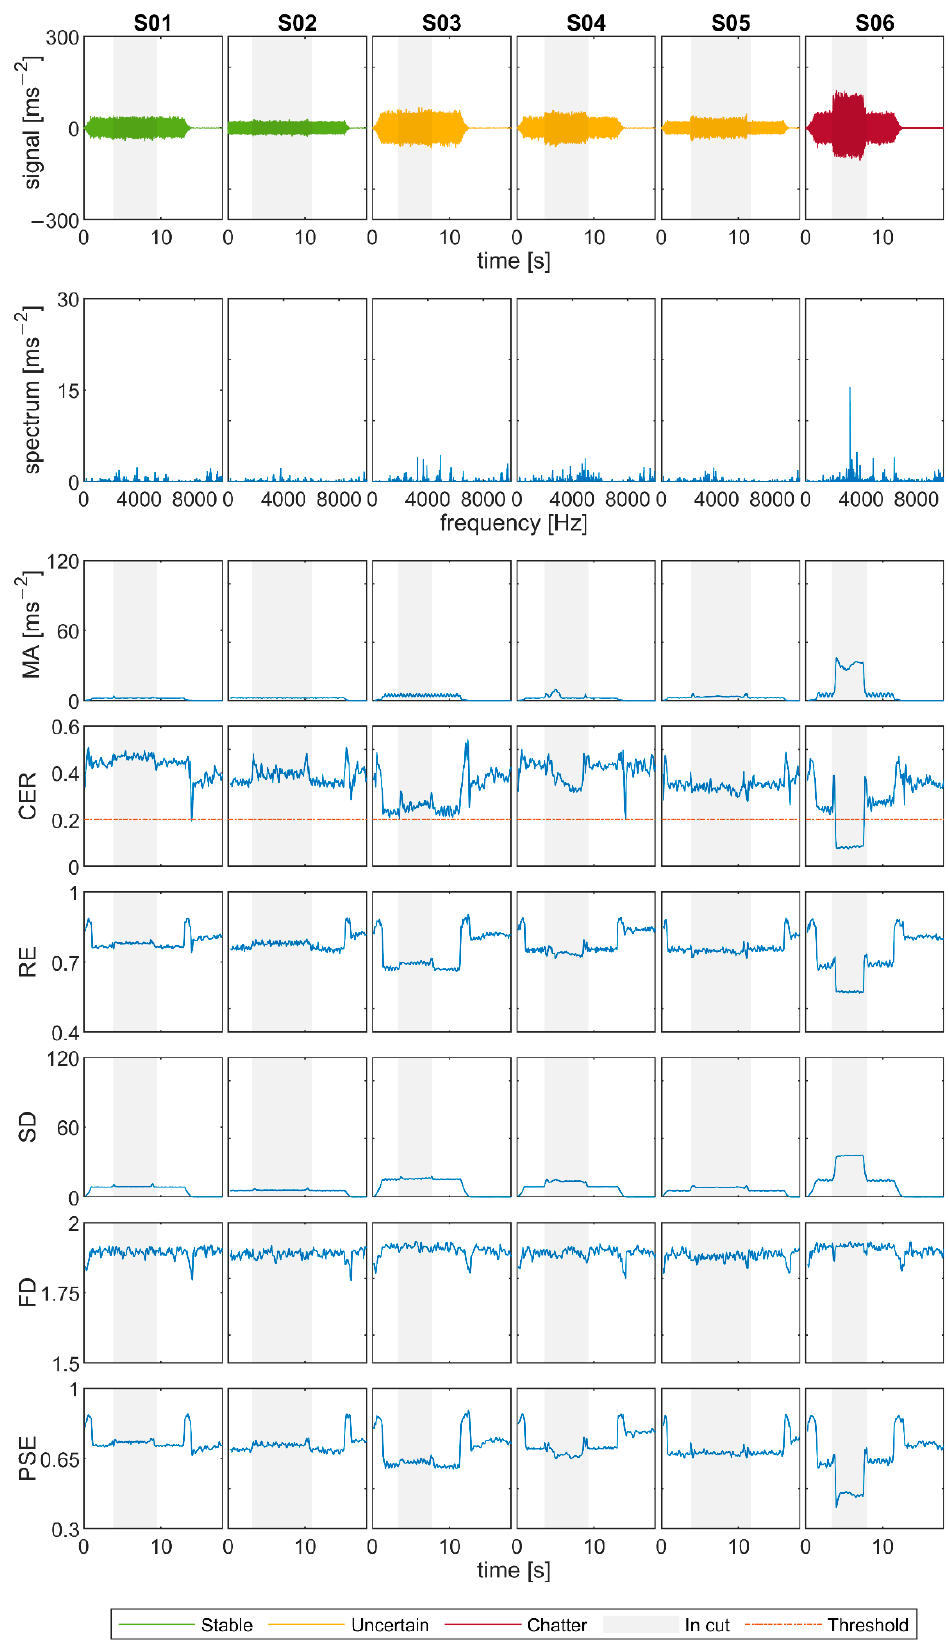
Figure A1. Signals from Experiment 1—slender end mill, overhang 50 mm.